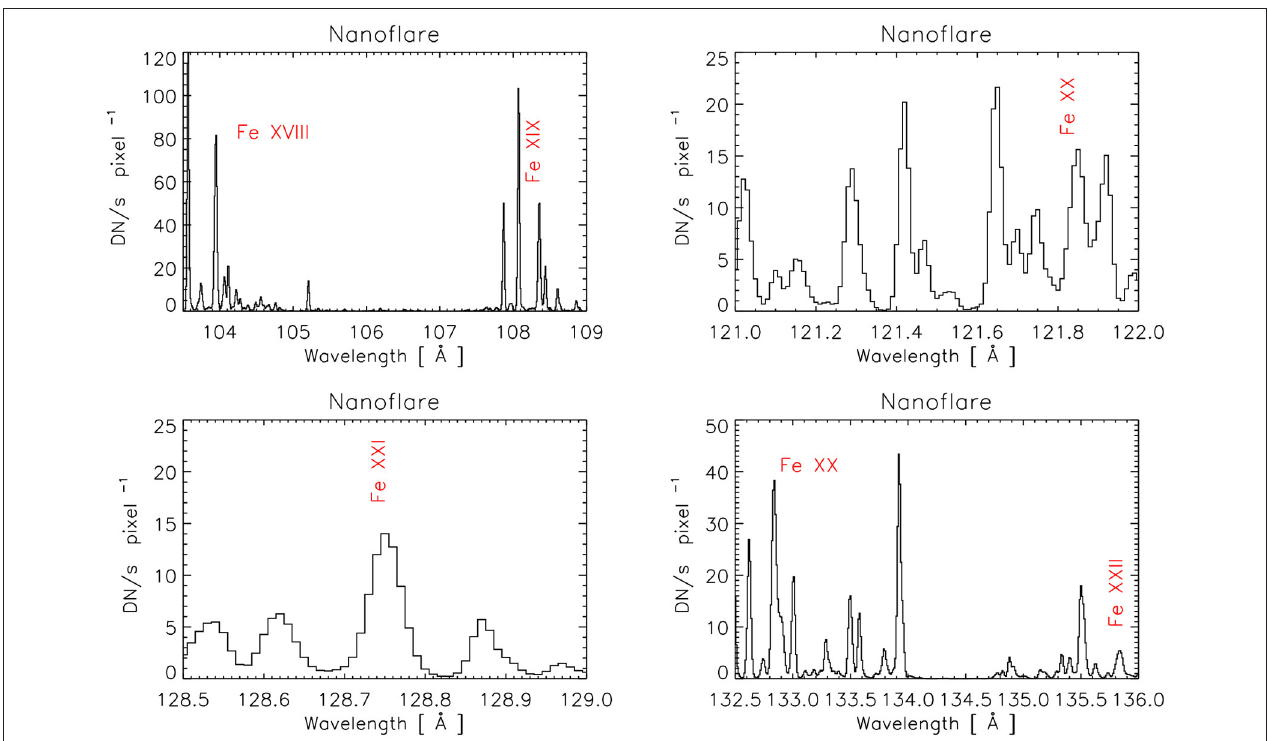
FIGURE 6 | Simulated count rates (1 ′′ pixel) for the emission from a nanoflare simulation (López Fuentes and Klimchuk, 2015). The main hot lines are labeled.